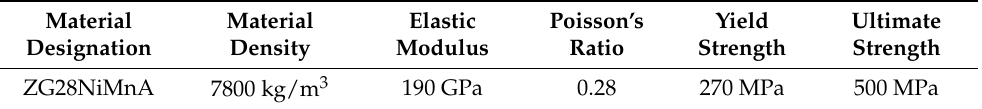
Table 2. Material property of the steering arm.